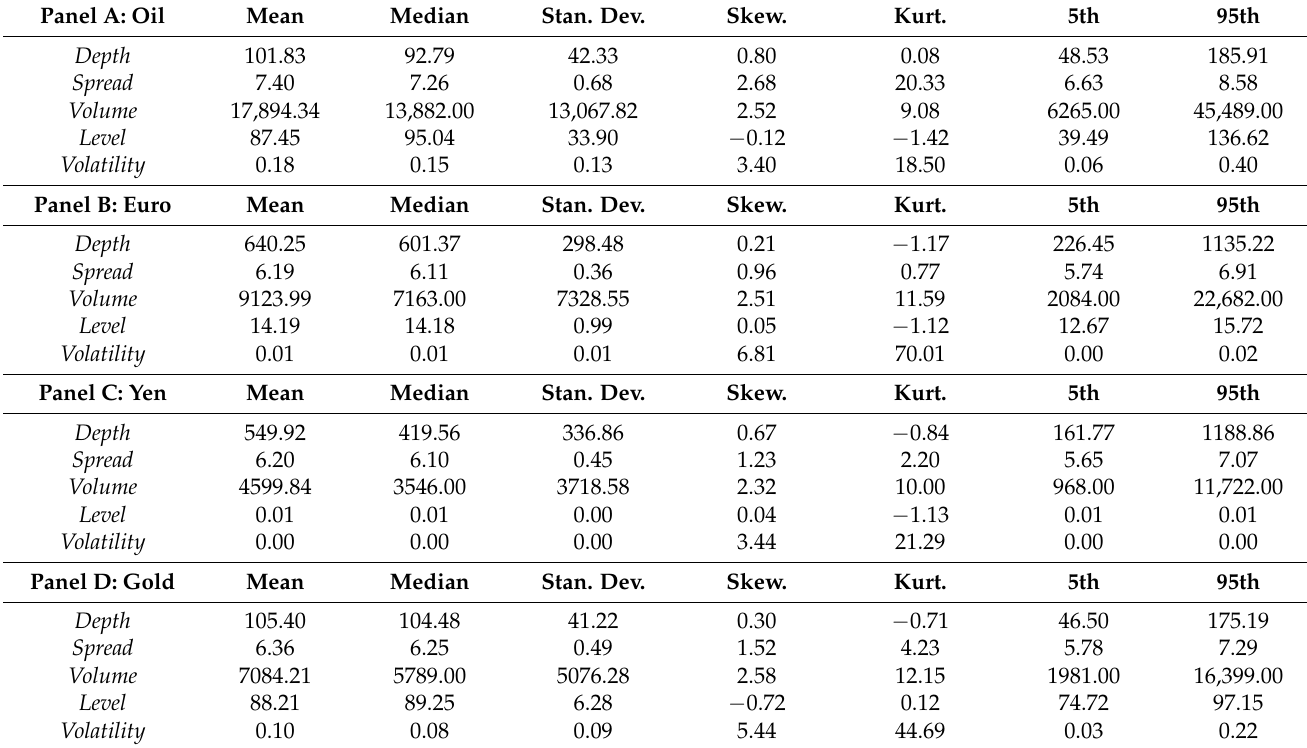
Table 2. Summary statistics.